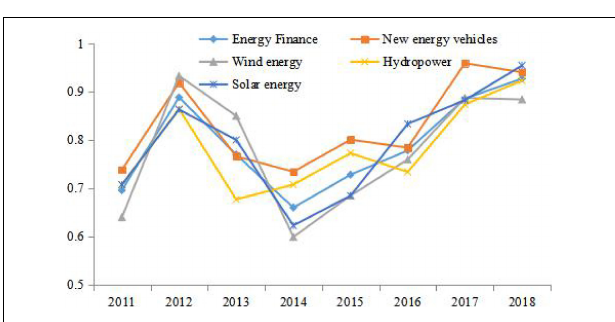
FIGURE 2 | Comprehensive efficiency of financial support for new energy industries.